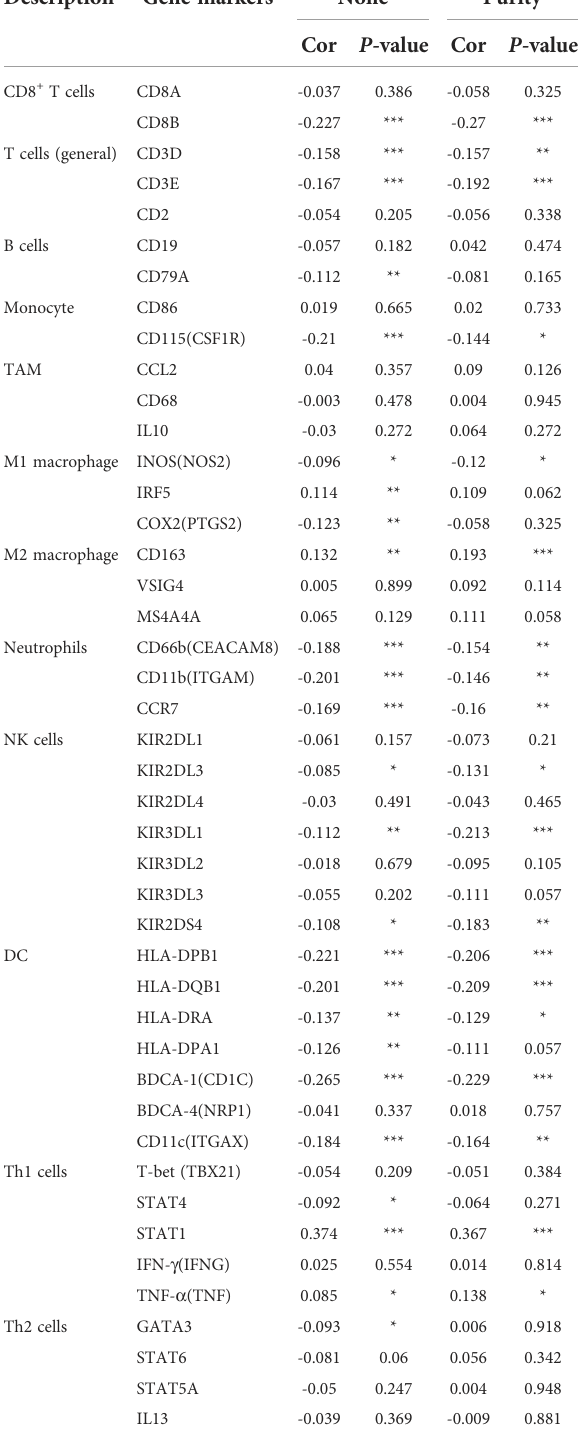
TABLE 4 Correlation analysis between RPP40 expression and immune cell markers in UCEC tumors.